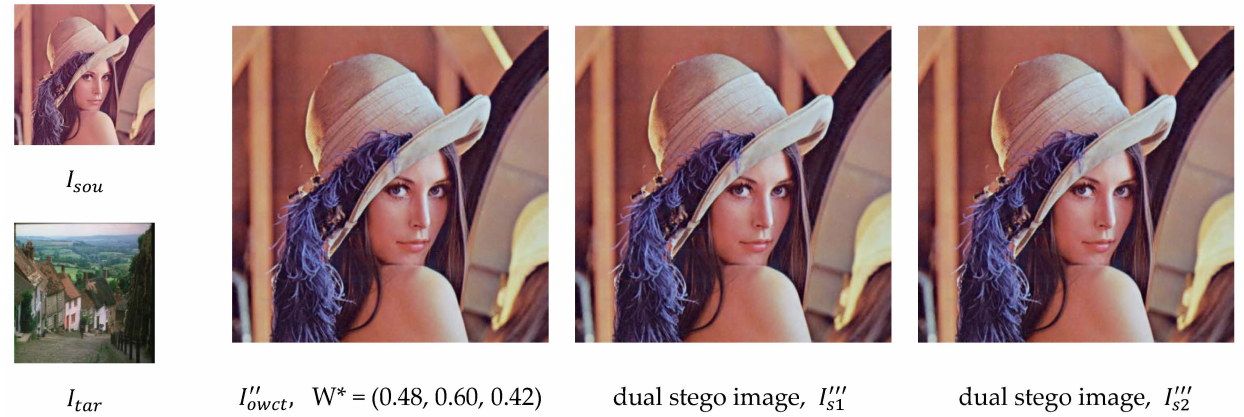
Figure 6. The visual inspection of the test image “Lena”.